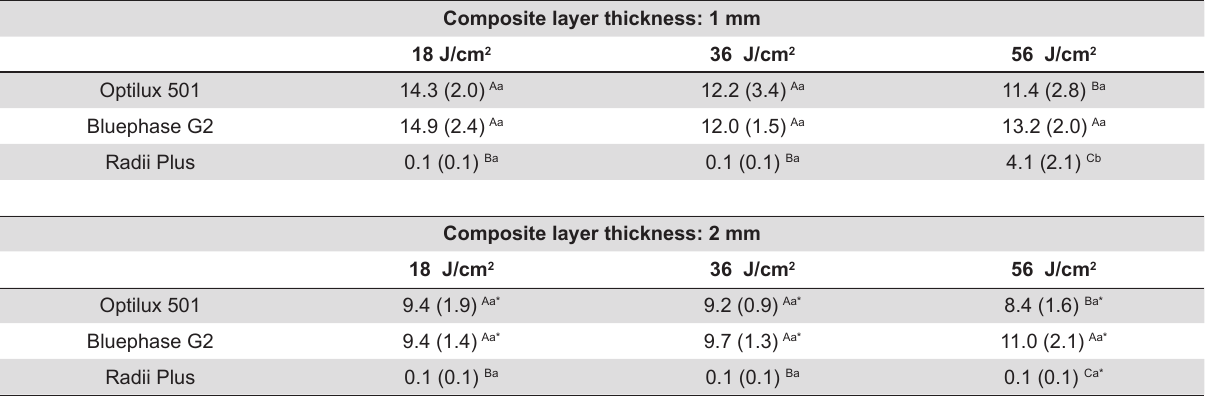
Table 4- Rpmax means (%) (standard deviation) of Lucirin-based RCs exposed to light from different curing units and delivered radiant exposure